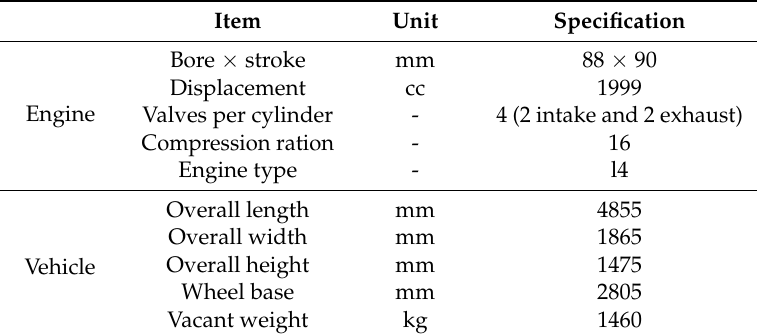
Table 1. Specification of the test vehicle used in this